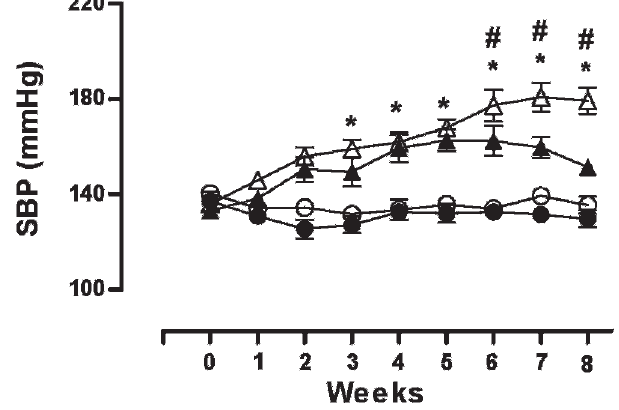
Figure 1 - The changes in systolic blood pressure (SBP, in mmHg) during the eight weeks of the study. Control (squares, n=15); L- NAME (diamonds, n=15); sildenafil (circles, n=15) and L-NAME + sildenafil (triangles, n=15). The data points and error bars represent the mean ¡ SEM. * p , 0.05 for L-NAME and L-NAME + sildenafil groups vs. control group. # p , 0.05 for L-NAME group vs. L-NAME + sildenafil group.